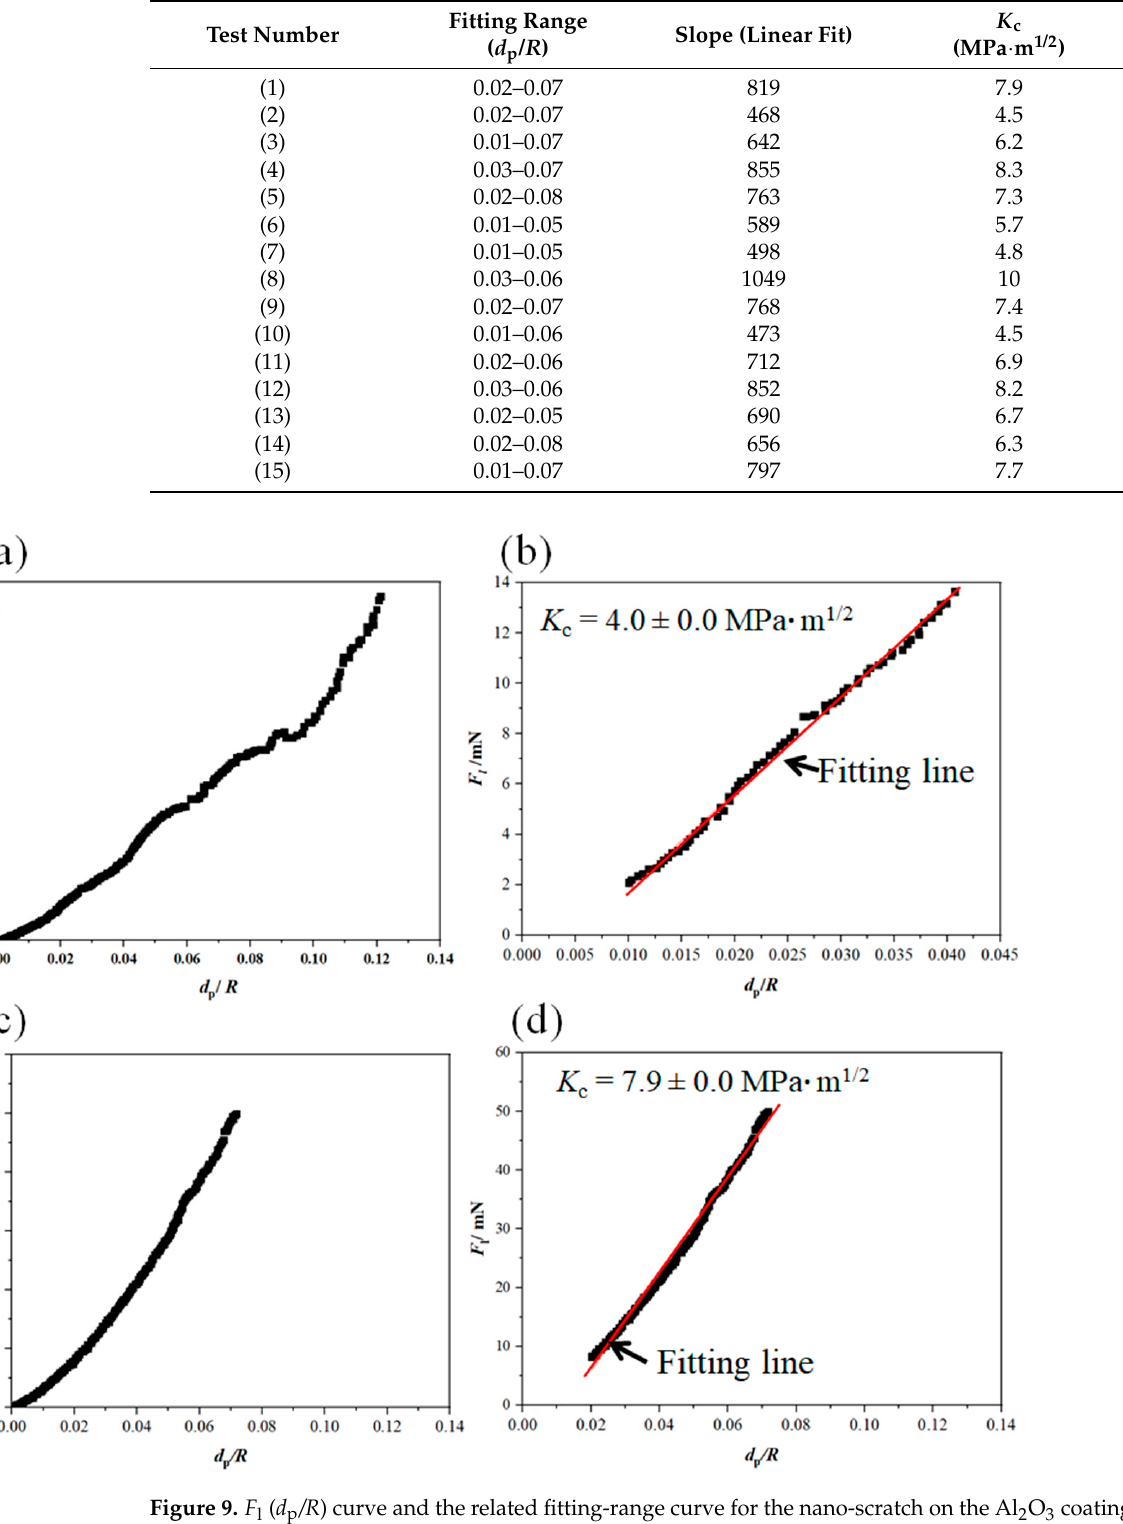
Table 3. The fitting range of F l ( d p /R ) curves and the related slopes used for the calculation of the fracture toughness of the Al 2 O 3 -ZrO 2 coatings.